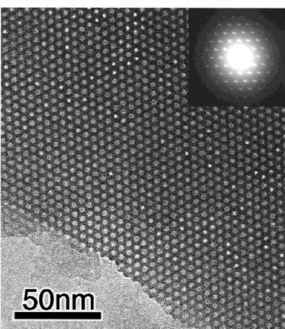
Figure 1. Transmission electron micrograph and electron diffraction pattern (inset) of periodic mesoporous organosilica (PMO) with two-dimensional (2D) hexagonal symmetry. Reprinted with permission from Reference [41]; copyright (1999) American Chemical Society.